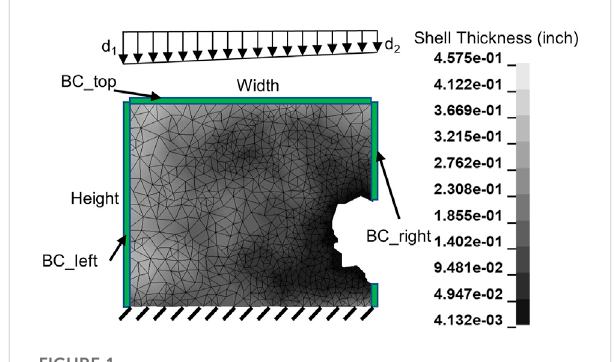
FIGURE 1 AtypicalcorrodedplateFEmodelofthebottomportionofaweb or stiffener plate for a corroded steel girder.